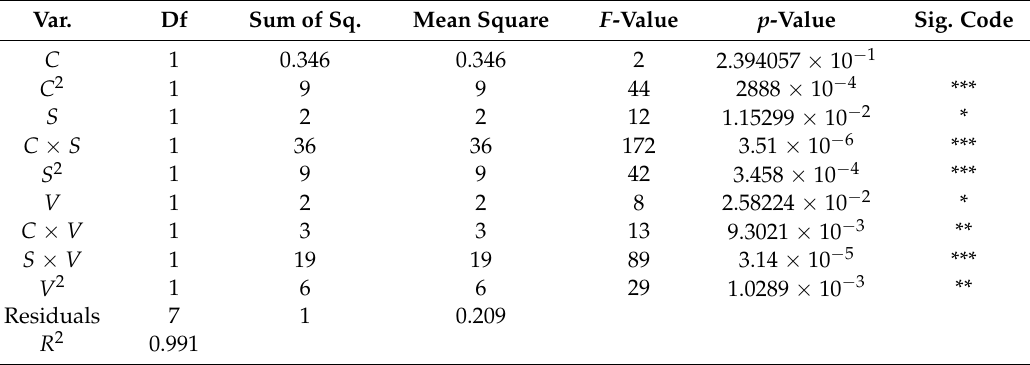
Table 4. ANOVA table for the “ R a ” quadratic